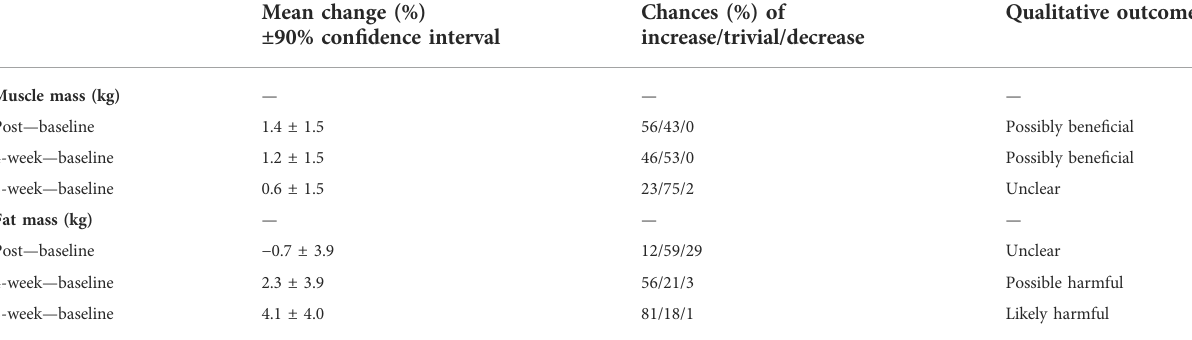
TABLE 5 Between group changes (IHE + Ex – Ex) in body fat % and muscle mass from baseline to post-intervention time